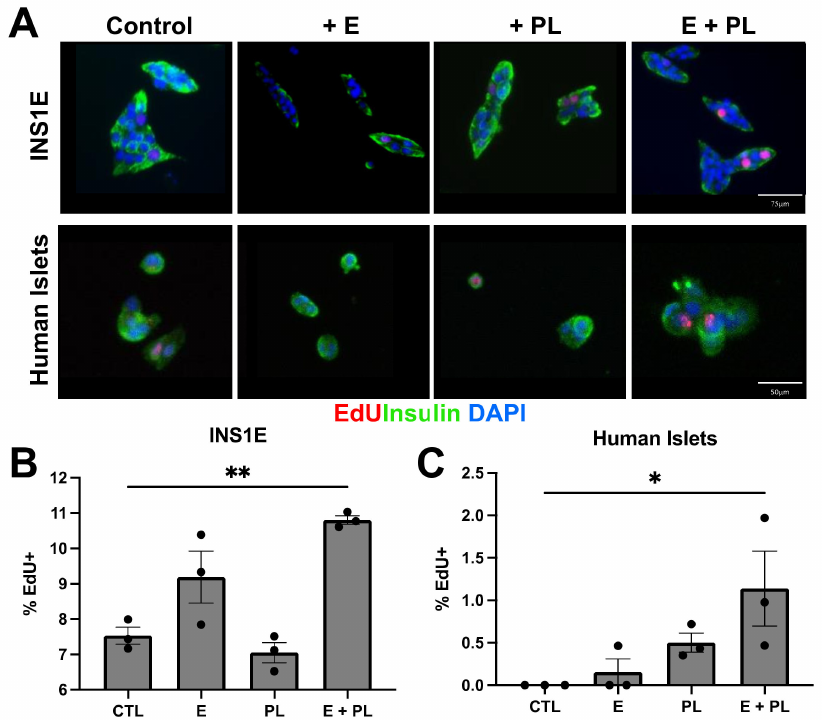
Figure 4. In-Vitro pseudopregnancy model promotes beta cell replication in human islets and INS1E cells. ( A ) Representative immunocytochemistry showing EdU incorporation (red) in beta cells (green) from the INS1E cell line (top row), and female human islets (bottom row) after treatment with E and PL. ( B ) Quantification of the proliferation of INS1E cells under the pseudopregnancy assay. INS1E control group and E + PL group (** p < 0.01) as well as between PL and E + PL ( p < 0.05) showed significant differences, n = 3. ( C ) EdU incorporation in female human islets treated with E and PL were statistically different from untreated control cells (* p < 0.05 by ANOVA); n =